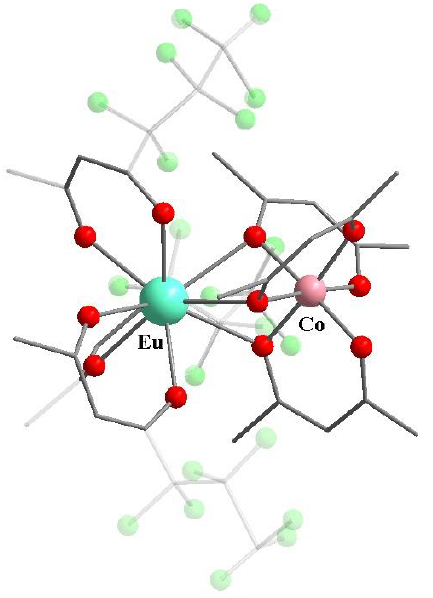
Figure 3. Molecular structure of 11 . Hydrogen atoms and some methyl groups have been omitted, C 3 F 7 groups of fod are transparent for clarity. The cif has been retrieved from CCDC. CCDC number is 1100888.